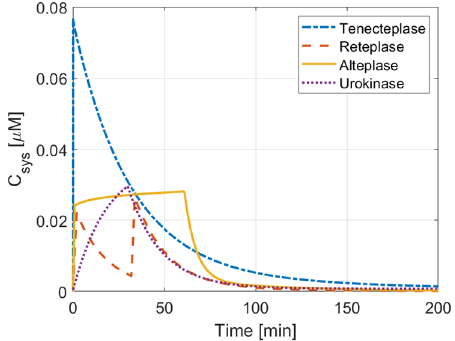
Figure 3. Systemic concentration profiles of different thrombolytic drugs.